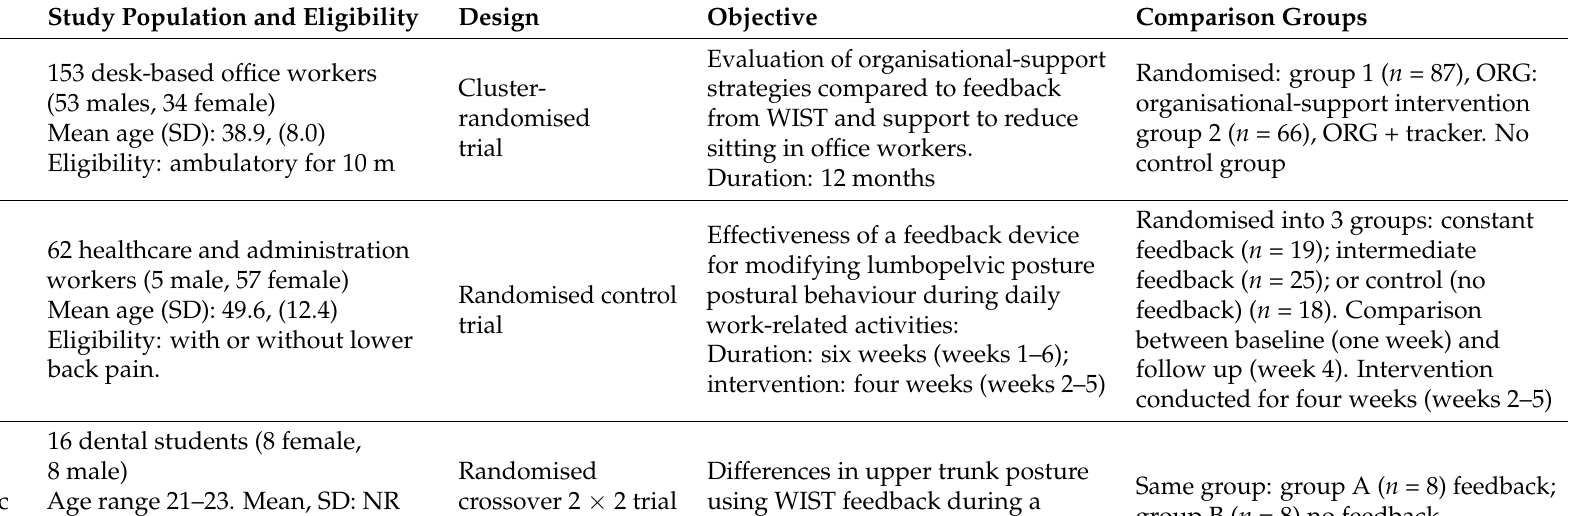
Table 2. Summary of study characteristics for included